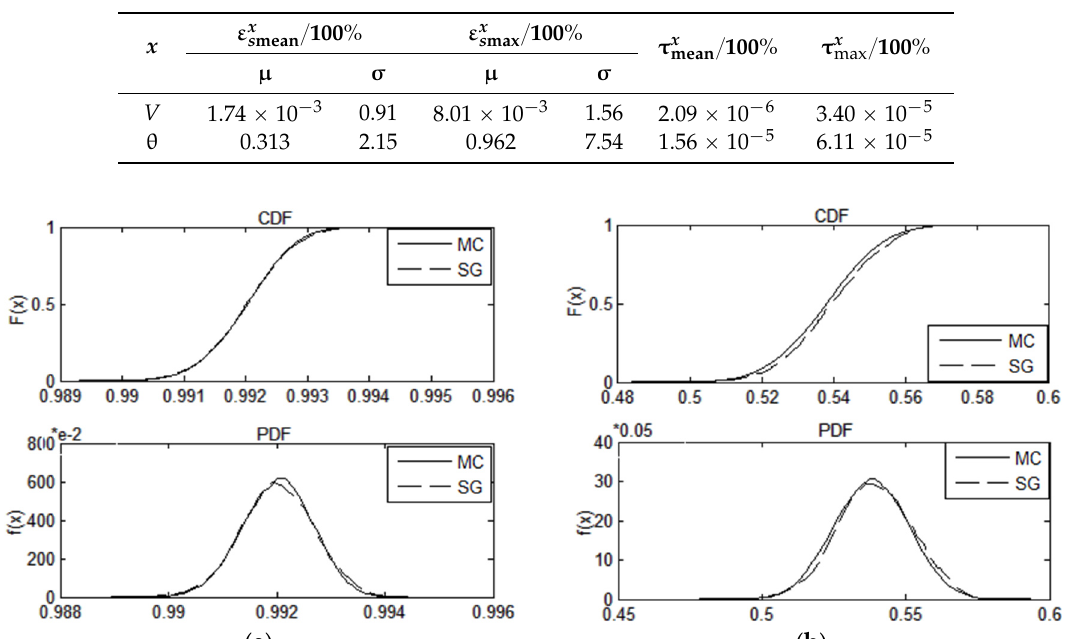
V and  in IEEE ‐ 118 system: ( a ) Figure 12. CDFs and PDFs of Figure 12. CDFs and PDFs of V 26 and θ 49 in IEEE-118 system: ( a ) V 26 (p.u.); ( b ) θ 49 49 26 Table 7. Mean and maximum ERs and ARMSs of 3 ‐ order SG ‐ PLF.